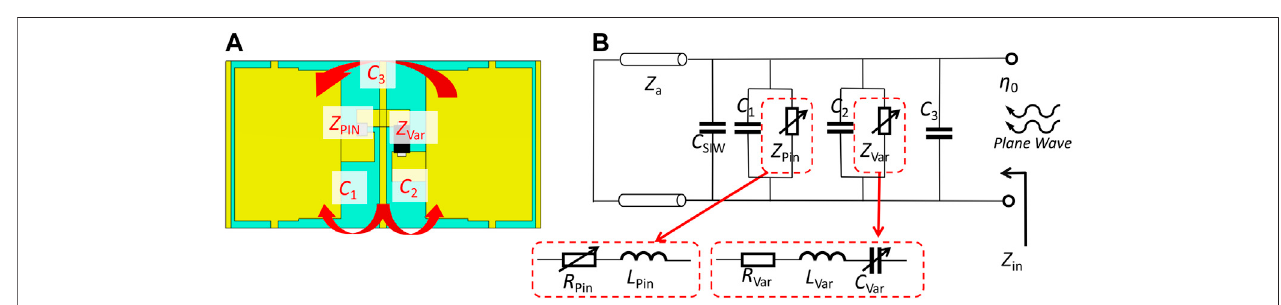
FIGURE 3 | (A) Equivalent capacitance between the surface patches. (B) The equivalent circuit model of the proposed programmable